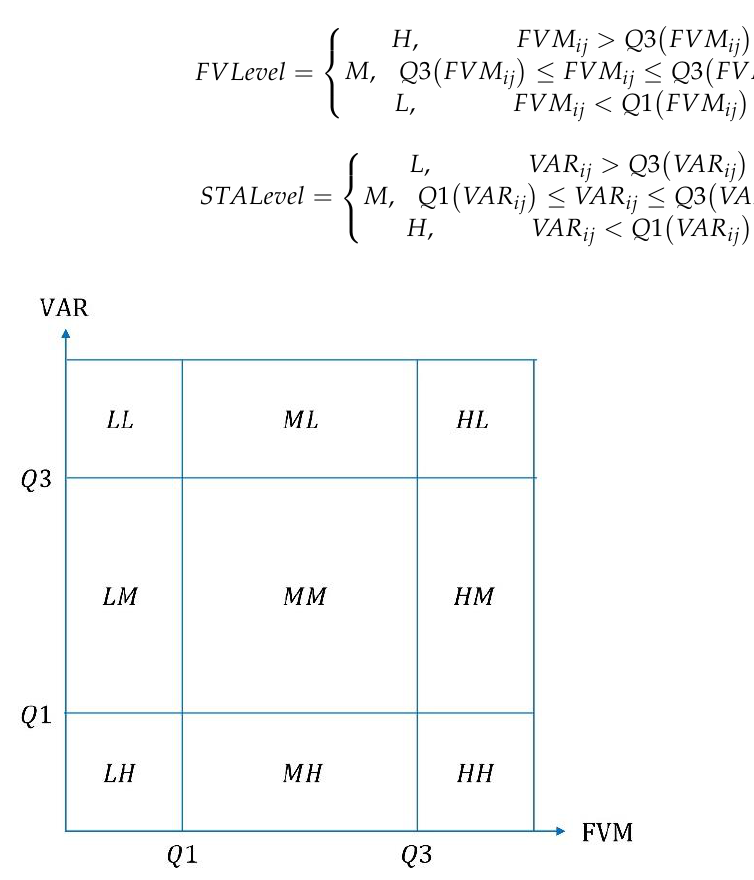
Figure 2. Flow and variability classification